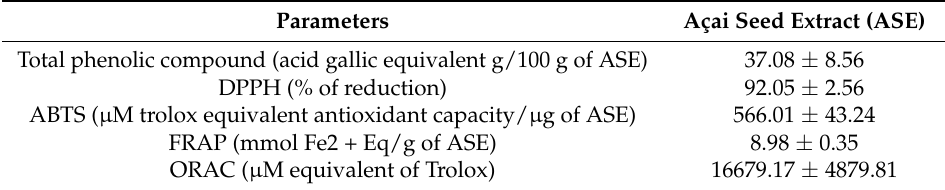
Table 1. Antioxidant activity and total phenolic compounds of Açai Seed Extract (ASE).